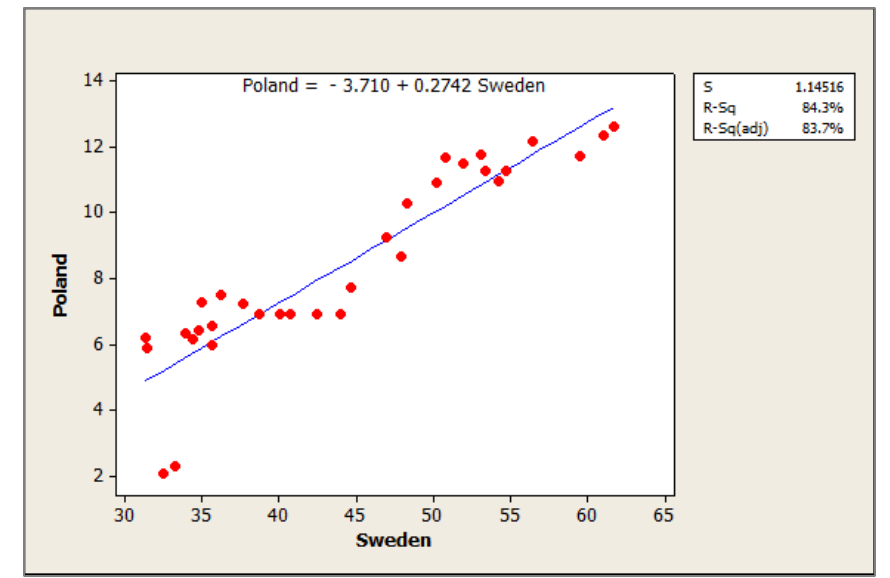
Figure 4. Poland’s and Sweden’s coefficient of RES.